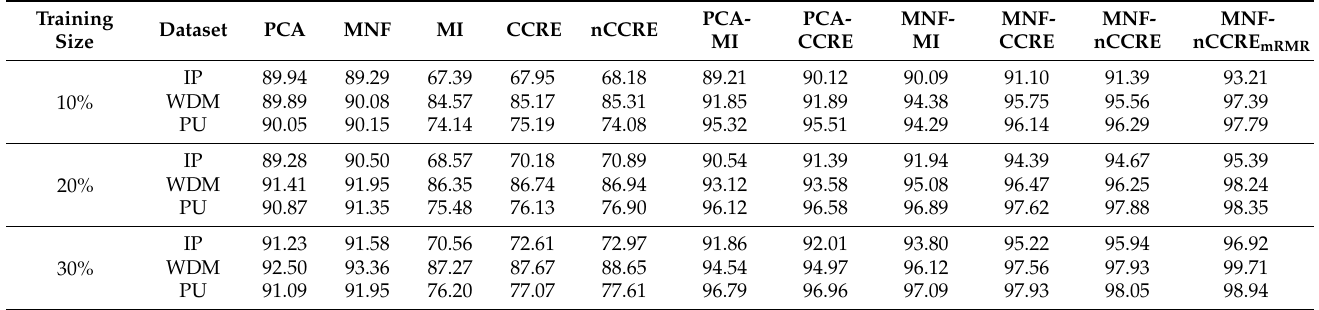
Table 12. OA measure using three different training: testing ratios on the three HSI datasets.